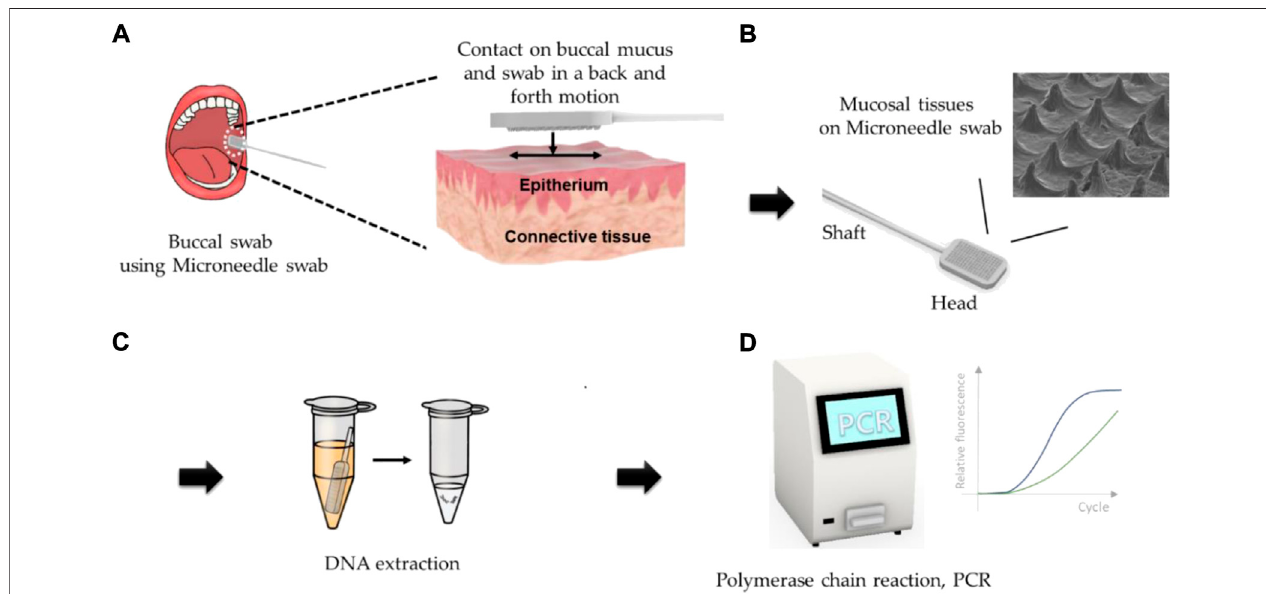
FIGURE1| Graphicaldescriptionsofoperationofmicroneedleswab (A) Theupperlayerofbuccalmucosaltissuewasobtainedbyswabbingthesurfaceofbuccal mucosausingthemicroneedleswab. (B) Obtainedsampleislocatedatthesurfaceofthemicroneedle. (C) SampleisreleasedtolysisbufferquicklyandDNAisextracted by swab lysis protocol. (D) Desired genetic information can be obtained through PCR process.